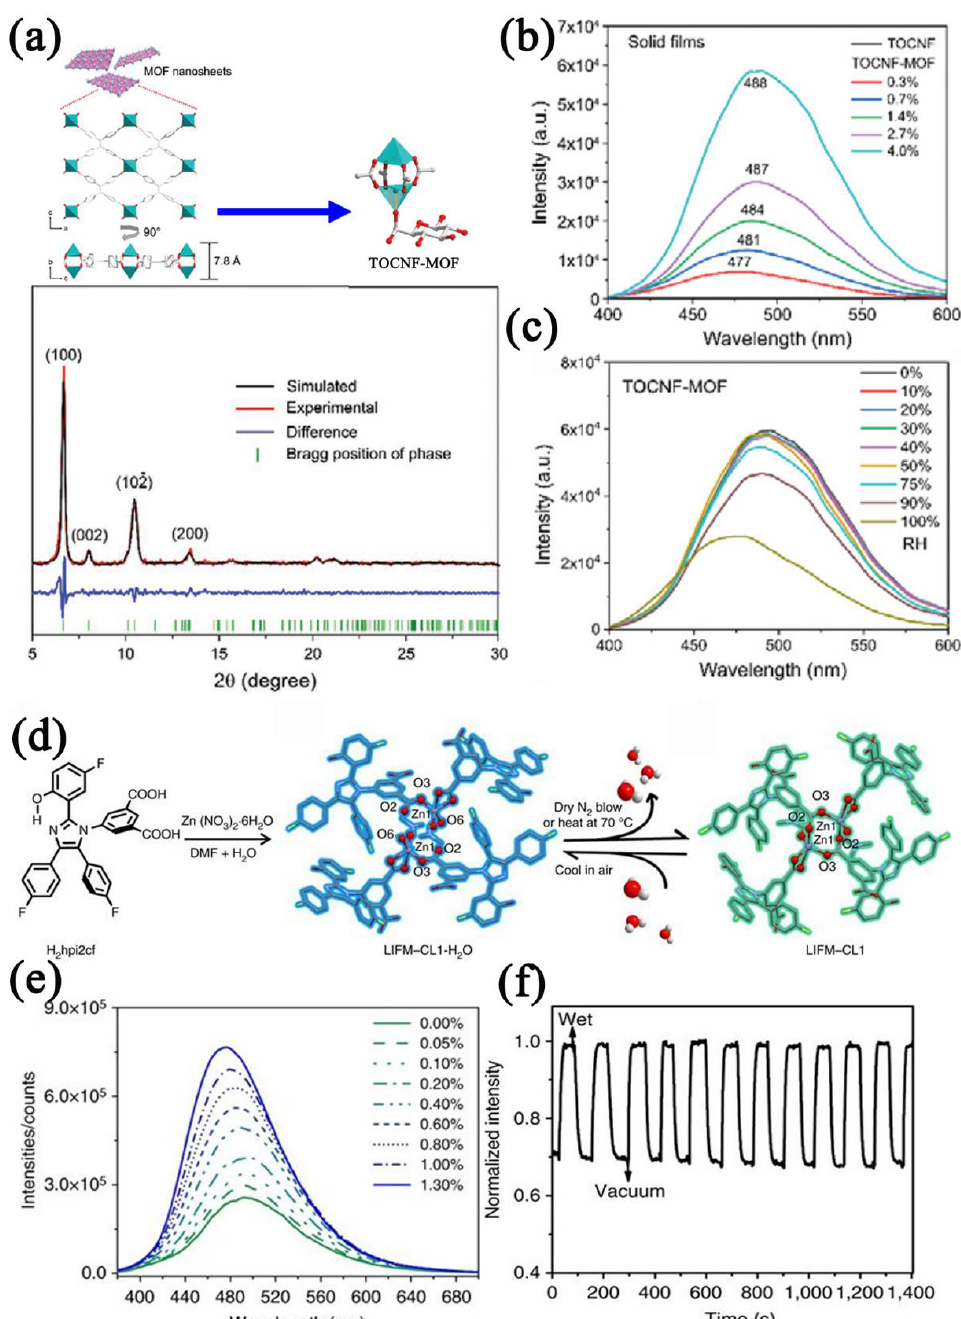
Figure 15. ( a ) Schematic diagram of ultrathin MOF nanosheets and TOCNF − MOF and the XRD patterns of MOF nanosheets. ( b ) Luminescent spectra ( λ ex = 365 nm) of TOCNF − MOF − based sensor in different MOF contents (0.3 – 4.0 wt%). ( c ) Luminescent spectra ( λ ex = 365 nm) of TOCNF − MOF − based sensor in the humidity ranges of 0 – 100% RH. Reproduced with permission from Ref. [56]. Copyright 2022, Wiley − VCH GmbH. ( d ) Synthetic route and structural transformation of Zn − MOF (left: ligand, middle: hydrated LIFM − CL1 − H 2 O (blue), right: dehydrated LIFM − CL1 (cyan)). ( e ) Luminescent spectra ( λ ex = 365 nm) of Zn − MOF − based sensor to different water contents (0 – 1.3% v / v ). ( f ) Cycling curve of Zn − MOF − based sensor between wet or vacuum atmospheres. Reproduced with permission from Ref. [131]. Copyright 2017, Springer Nature.